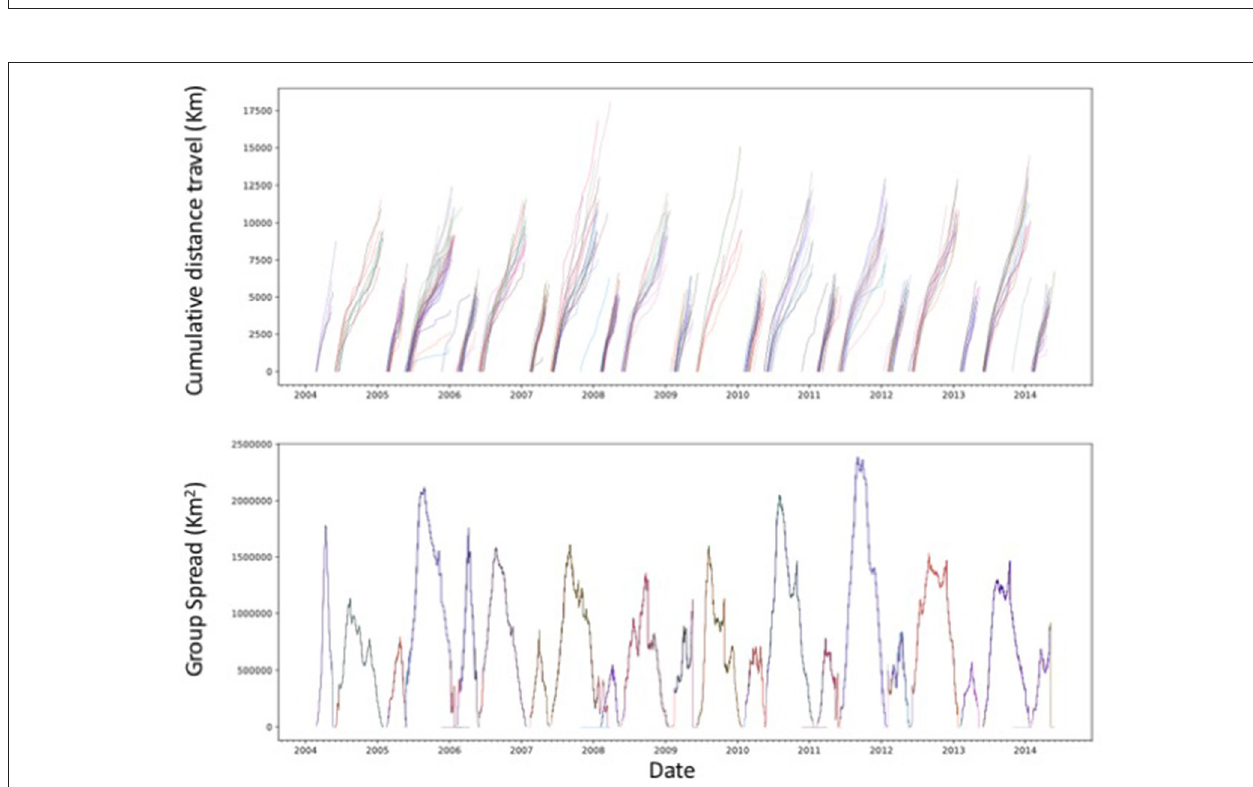
FIGURE 6 | Cumulative distance traveled, from departure to return to the rookery, by the tagged northern elephant seals and the spatial spread of each seal group during the study period. Each line in the upper panel represents a different tagged individual.